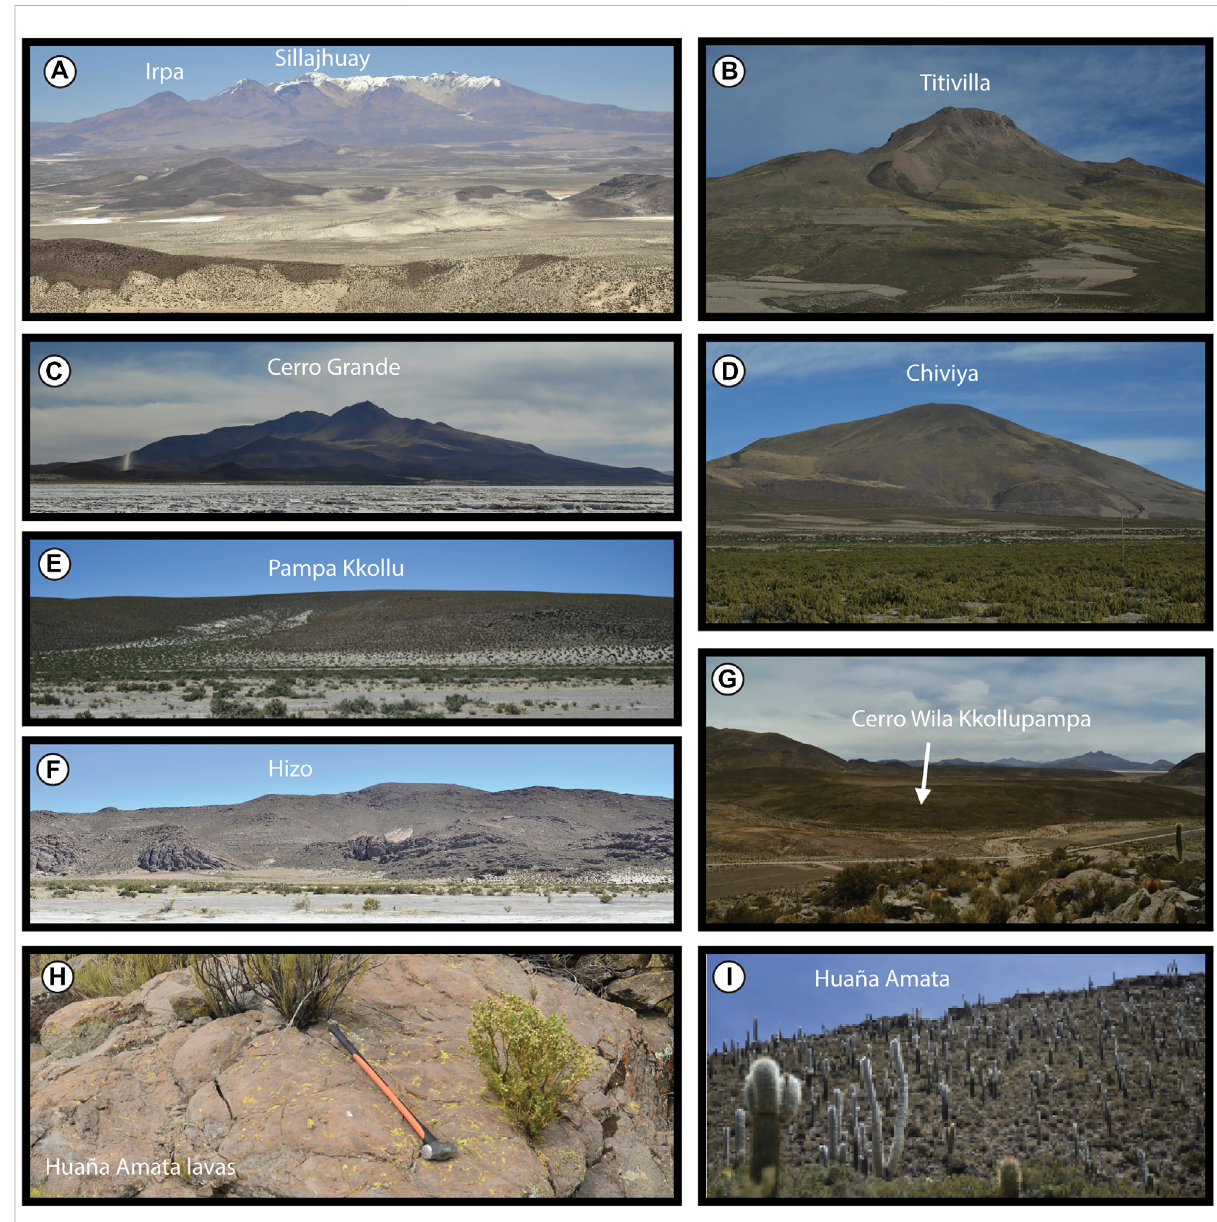
FIGURE 2 FieldphotographsshowingexamplesofIntersalarRangevolcanism. (A) ViewtowardsthearccompositecentersofSillajhuayandIrpavolcanoes along the Bolivia/Chile Border, image taken from Chiviya volcano. (B – D) Rear arc composite centers Titivilla, Grande, and Chiviya. (E – F) Smaller siliciccentersinthewesternIntersalarRange:PampaKkolluandapreviouslyunnamedcenternearestanciaHizo. (G) CerroWilaKkollupampa,oneof the fi ve, broad, fl at-topped, relatively ma fi c tortas sampled in the eastern Intersalar Range. (H – I) Miocene Huaña Amata volcanic center showing typical examples of weathering and vegetation of the Intersalar